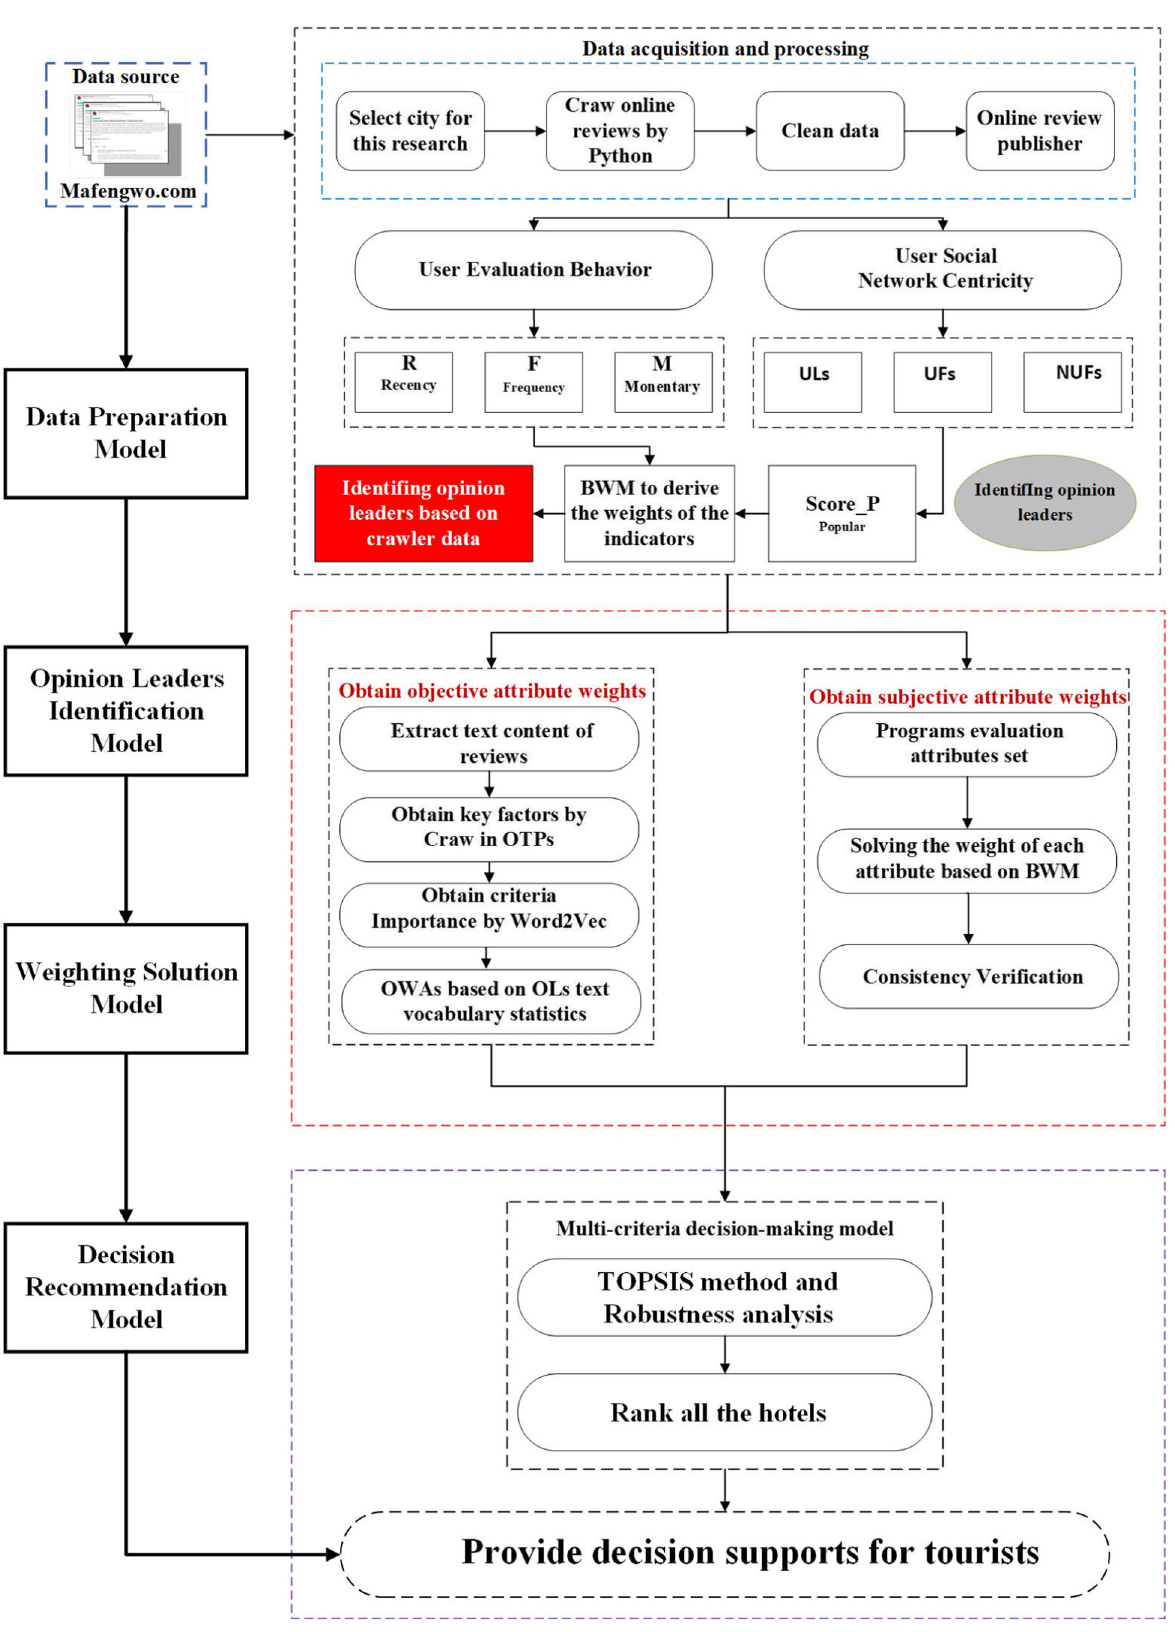
Fig. 2 The structure of the proposed decision support model for